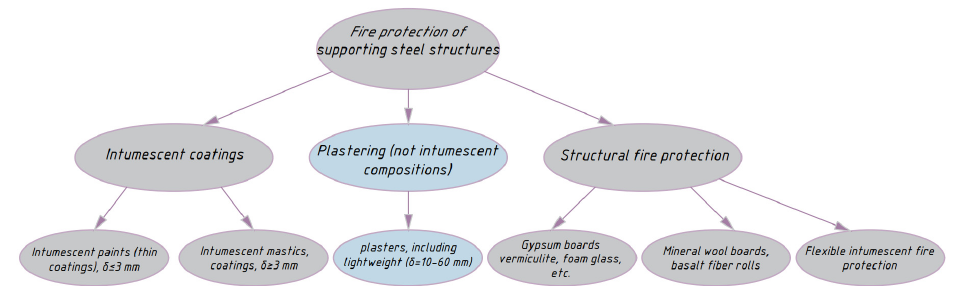
Figure 1. Means and methods of fire protection of steel